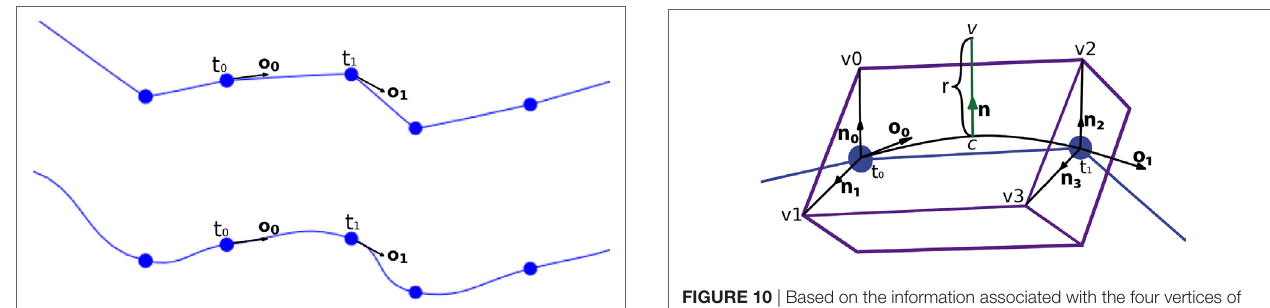
FIGURe 8 | Top image: original neurite path. Bottom image: smoothed path using cubic Hermite spline